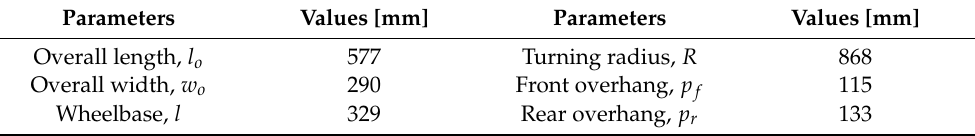
Table 1. The model car